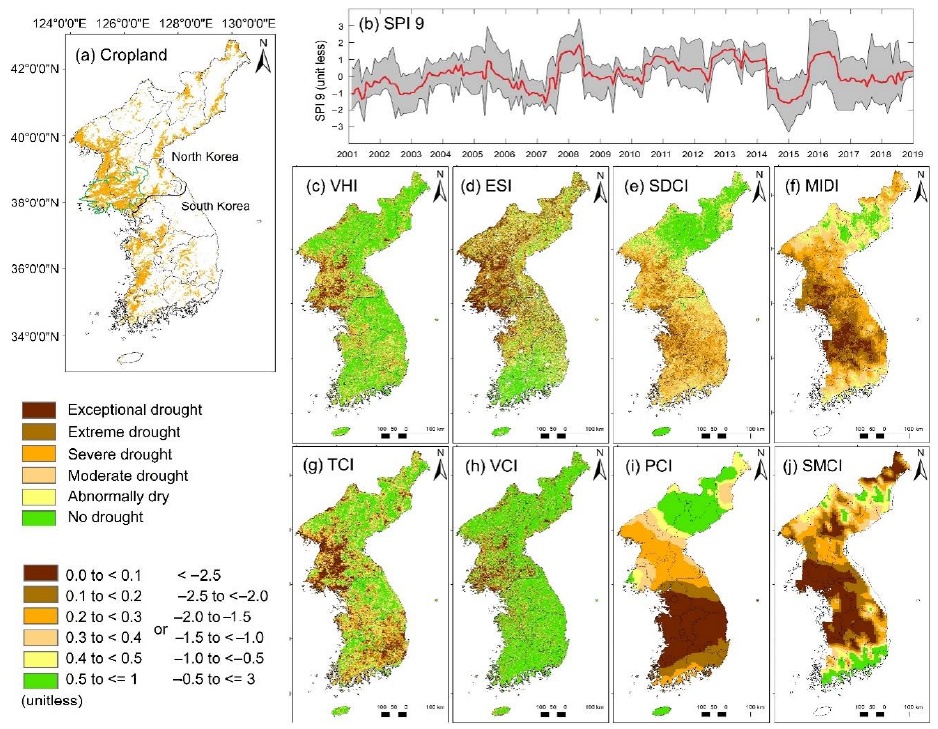
Figure 3. Spatial distribution of drought indices over North Korea and South Korea in July 2015. ( a ) Spatial map of cropland from MODIS products, ( b ) Time series of SPI 9 from 2001 to 2018. The average of SPI 9 from 61 stations is shown by the dashed red line. Shaded lines indicate minimum and maximum range of SPI 9 from 61 stations. ( c – j ) represent maps of each drought index.